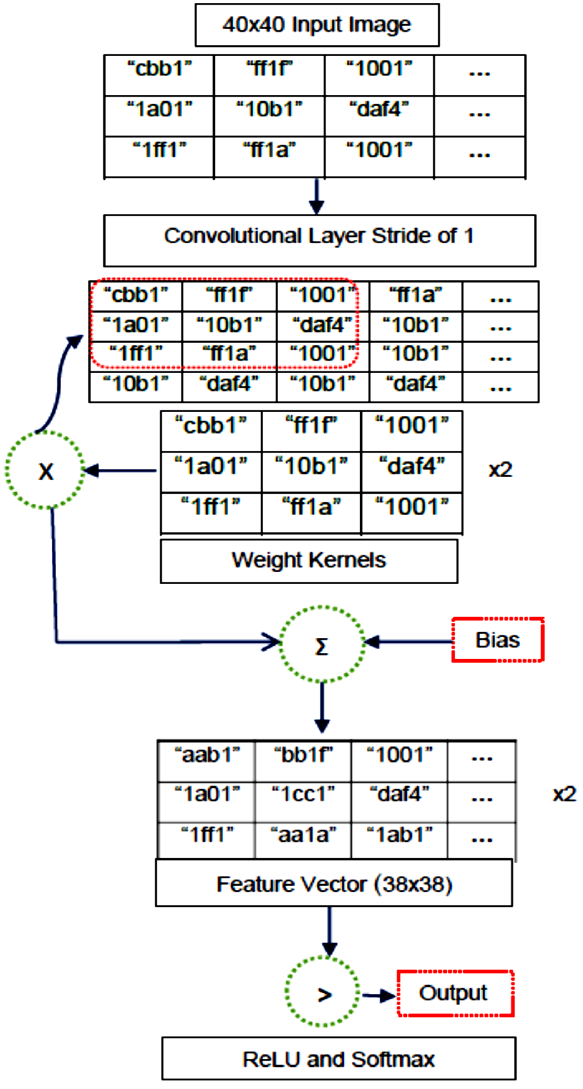
Figure 13. Layer structure and processes of the custom CNN.